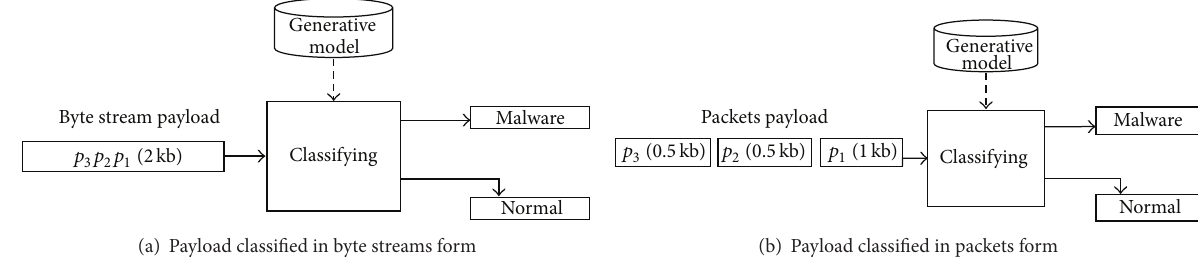
Figure 1: Classification process for stateful and stateless level.